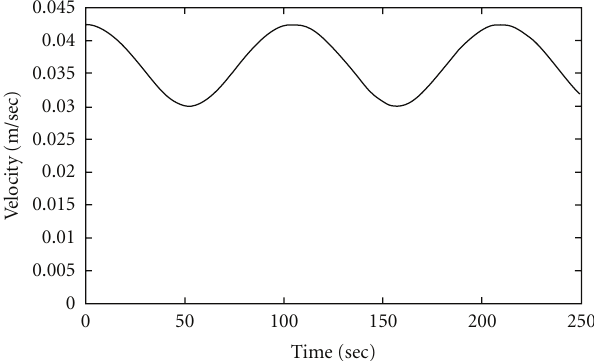
Figure 13: Plot of velocity versus time for sinusoidal motion of